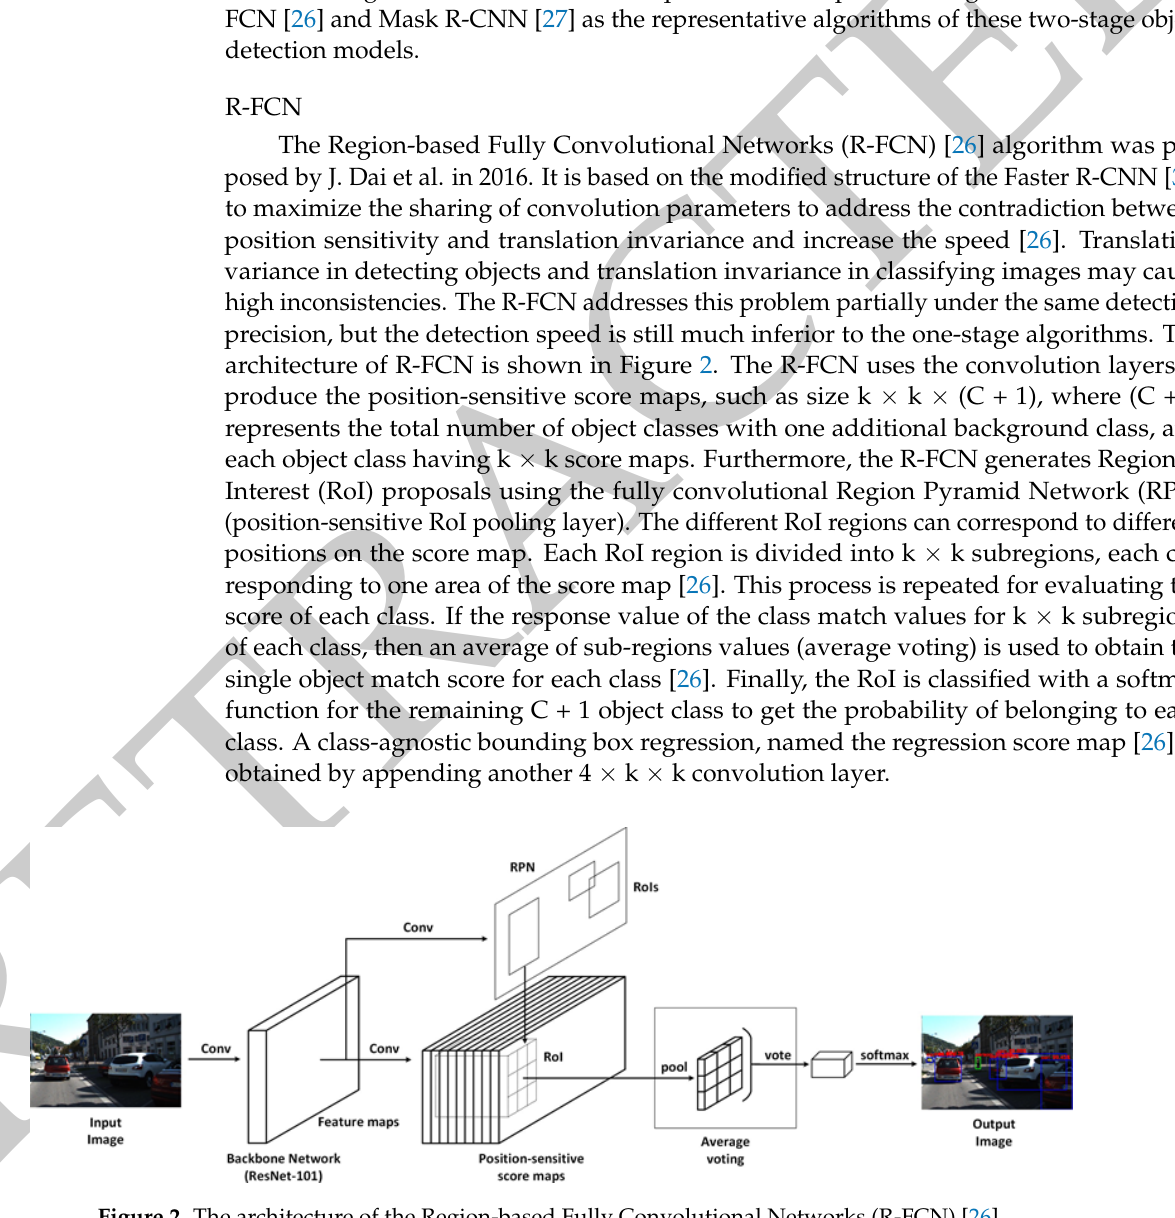
Figure 2. The architecture of the Region-based Fully Convolutional Networks (R-FCN) [26] . Mask